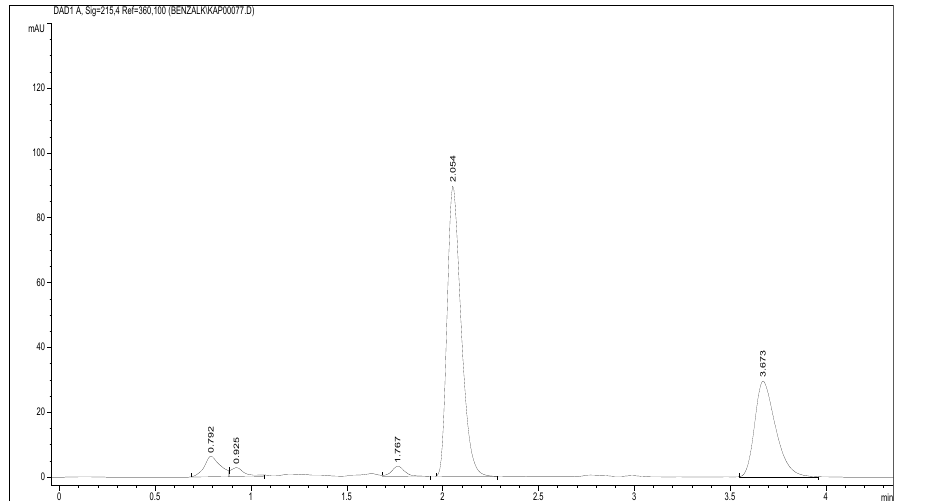
Figure 1. Representative chromatograms of BKC standard solution (20µgml -1 ) Linearity.